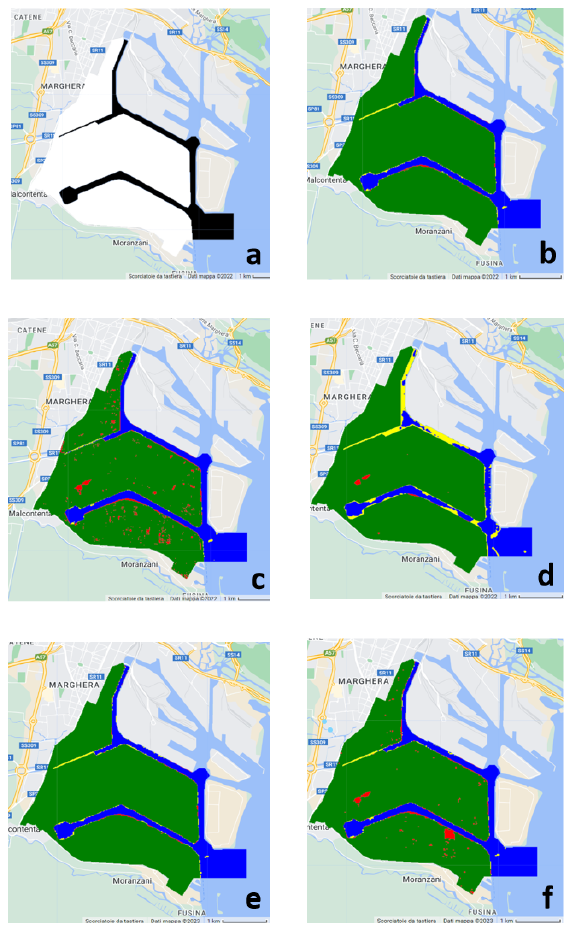
Table 5. Metrics of HSV approach with a time range of three Figure 8. Ground truth mask (a) and water detection masks months (Landsat-8). obtained with the first approach on Sentinel imagery (b) and Landsat imagery (e), the second approach on Sentinel imagery (c) and Landsat imagery (f), and the third approach (d) (Marghera dock, January-March 2019). True positives are in blue, true negatives in green, false positives in red and false negatives in yellow. Table 6. Metrics of the SAR approach with a time range of three months